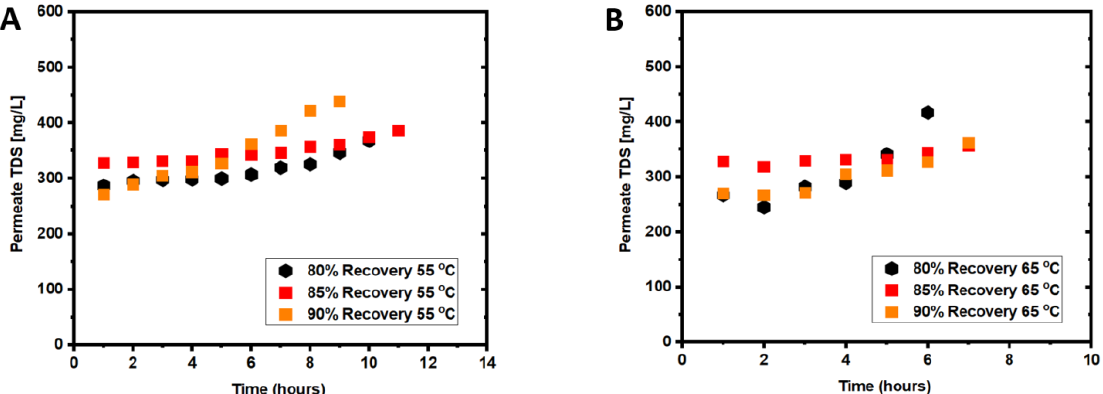
Table 3. Elemental composition (wt%) of pristine and fouled membranes by seawater and landfill leachate. Figure 6. ( A ) Permeate TDS concentrations at 55 ◦ C for 80%, 85%, and 90% recoveries; ( B ) permeate Figure 6. ( A ) Permeate TDS concentrations at 55 ° C for 80%, 85%, and 90% recoveries; ( B ) permeate TDS concentrations at 65 ◦ C for 80%, 85%, and 90% TDS concentrations at 65 ° C for 80%, 85%, and 90% recoveries.